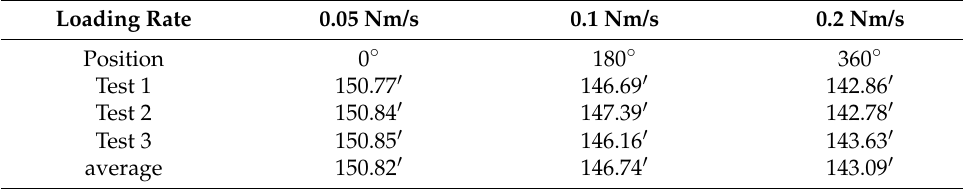
Table 4. Experiment results of δ .